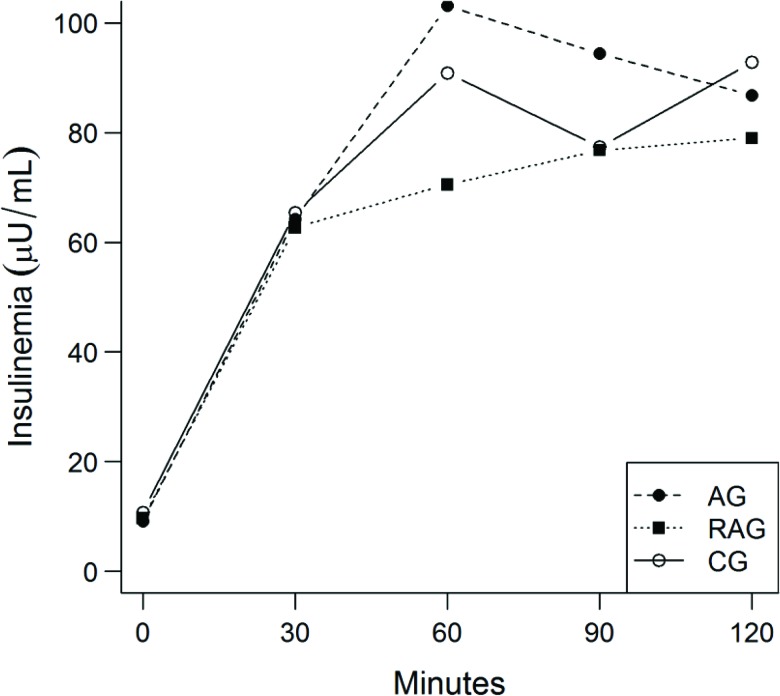
Insulinemia with time for the aerobic training group (AG), resistance and aerobic training group (RAG) and control group (CG).